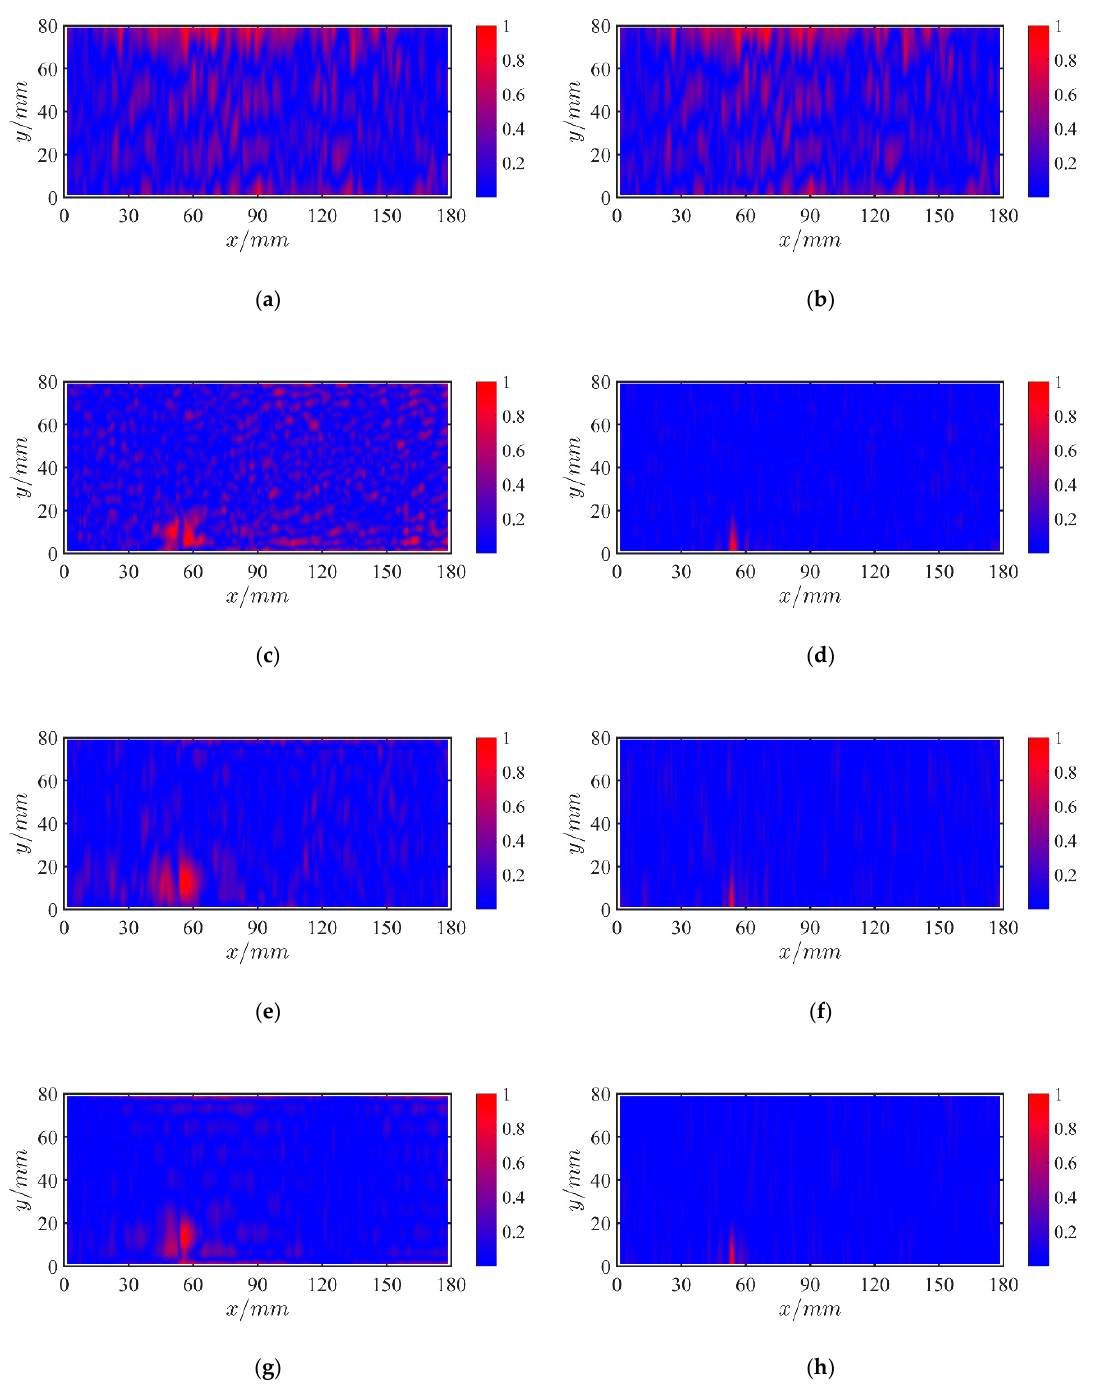
Figure 9. The RDIs colored plot of first four modes of a single crack plate. ( a ) RDIs of the first mode in the x direction. ( b ) RDIs of the first mode in the y direction. ( c ) RDIs of the second mode in the x direction. ( d ) RDIs of the second mode in the y direction. ( e ) RDIs of the third mode in the x direction. ( f ) RDIs of the third mode in the y direction. ( g ) RDIs of the fourth mode in the x direction. ( h ) RDIs of the fourth mode in the y direction.